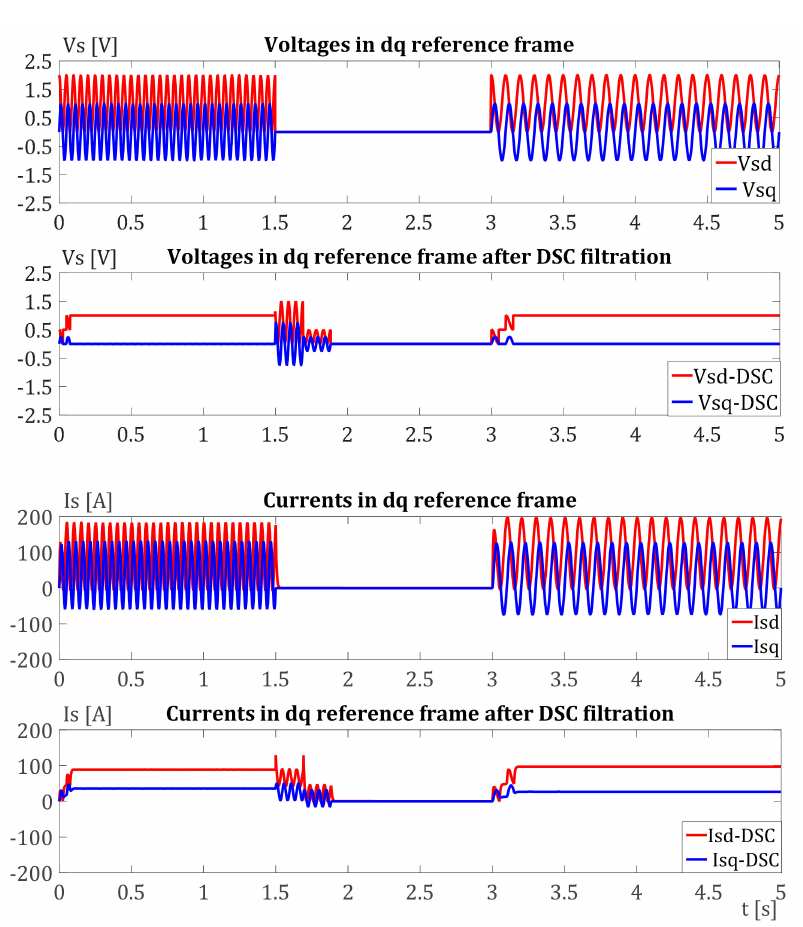
Figure 2. Results of the computer simulation- dq voltage and currents before and after cascade DSC filter.